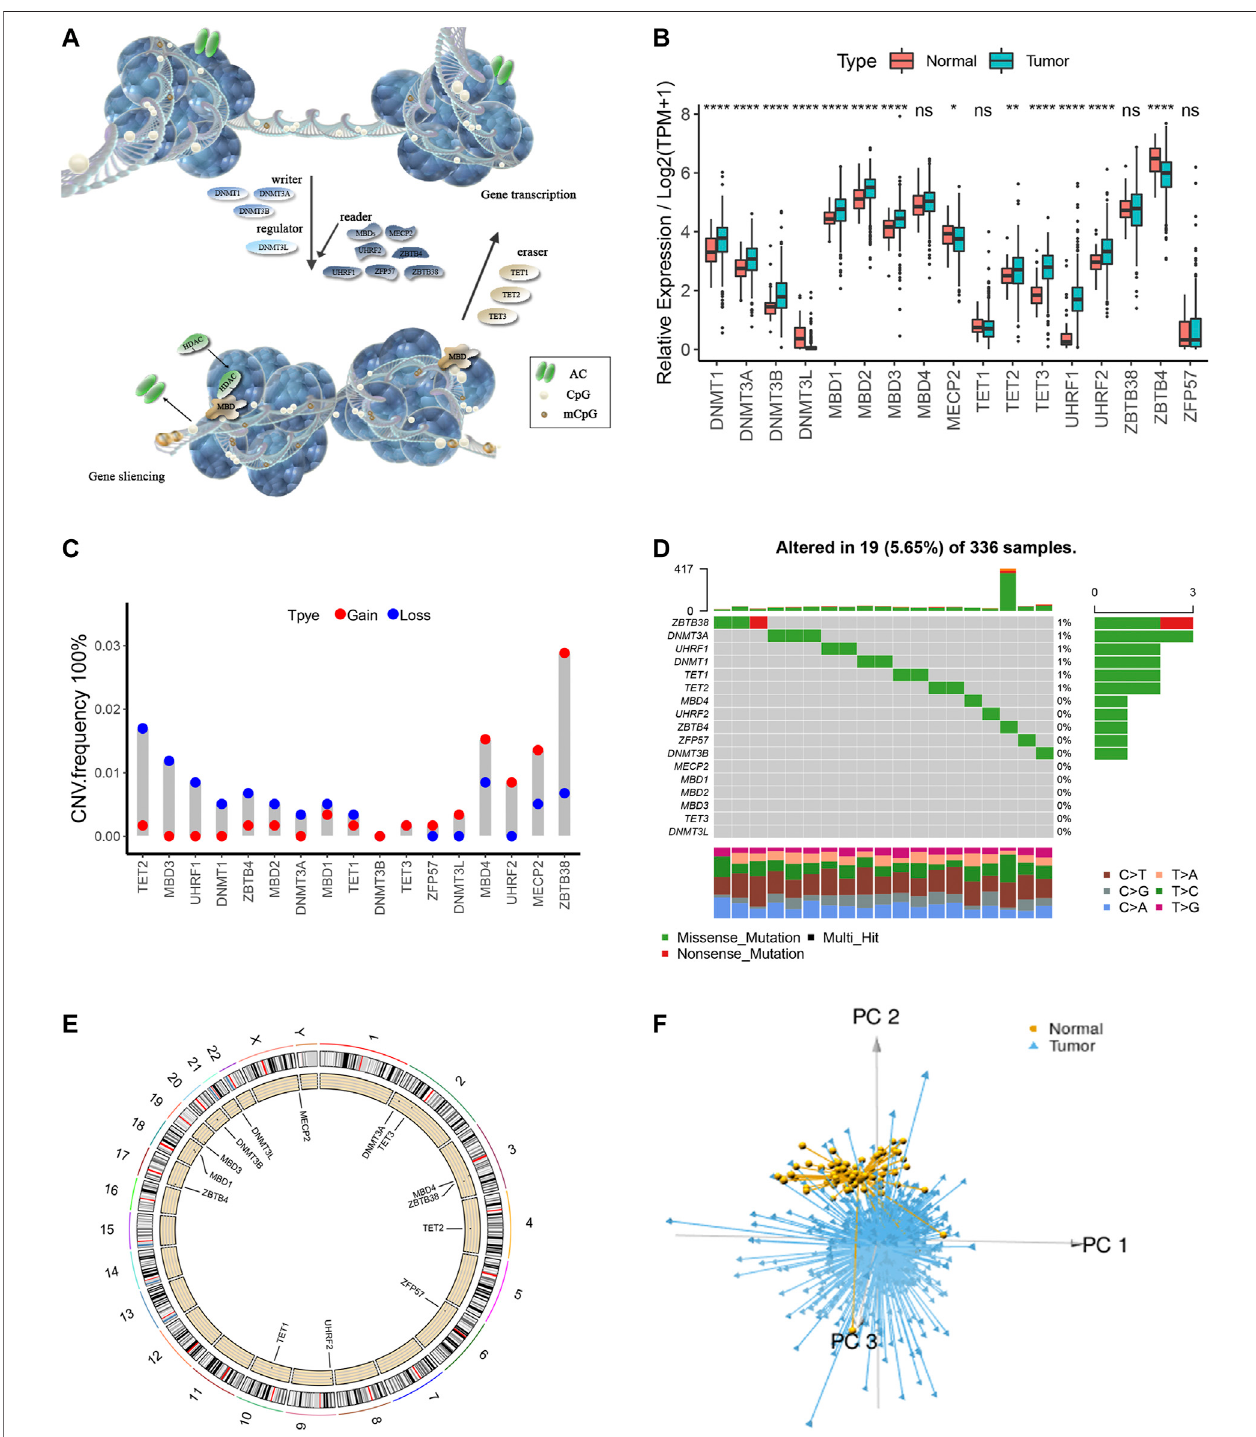
FIGURE 1 | The overall depiction of genetic variations of m 5 C regulators in ccRCC. (A) The dynamic reversible process of m 5 C DNA methylation mediated by regulatorsaswellastheirpotentialbiologicalfunctionsforccRCCaresummarized. (B) Comparisonoftheexpressionlevelsof17 m 5 Cregulatorsin530ccRCCsamples and > 12,000 para-cancer tissues. (C) Copy number variations (CNVs) of the 17 m 5 C regulators in ccRCC from TCGA cohort. (D) Somatic variant landscape of the 17 m 5 C regulators in ccRCC from TCGA cohort. (E) The location of CNV alterations of m 5 C regulators on chromosomes. (F) Principal component analysis of ccRCC samples from the TCGA cohort based on the expression of the 17 m 5 C regulators.